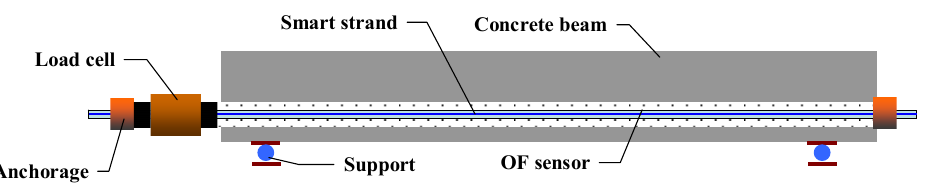
Figure 8. Scheme of sensor location in the prestressed concrete beam.